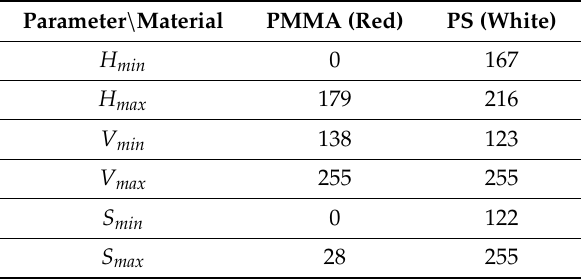
Table 1. Filtration parameters defined by HSV ranges.